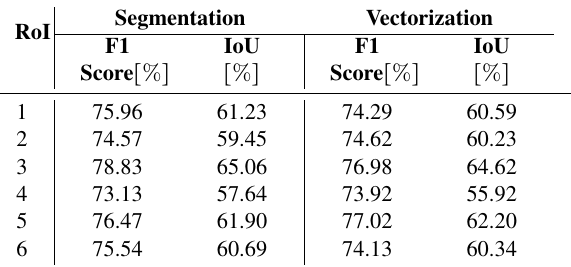
Table 2. F1 score and IoU results of building segmentation in GF-7 satellite